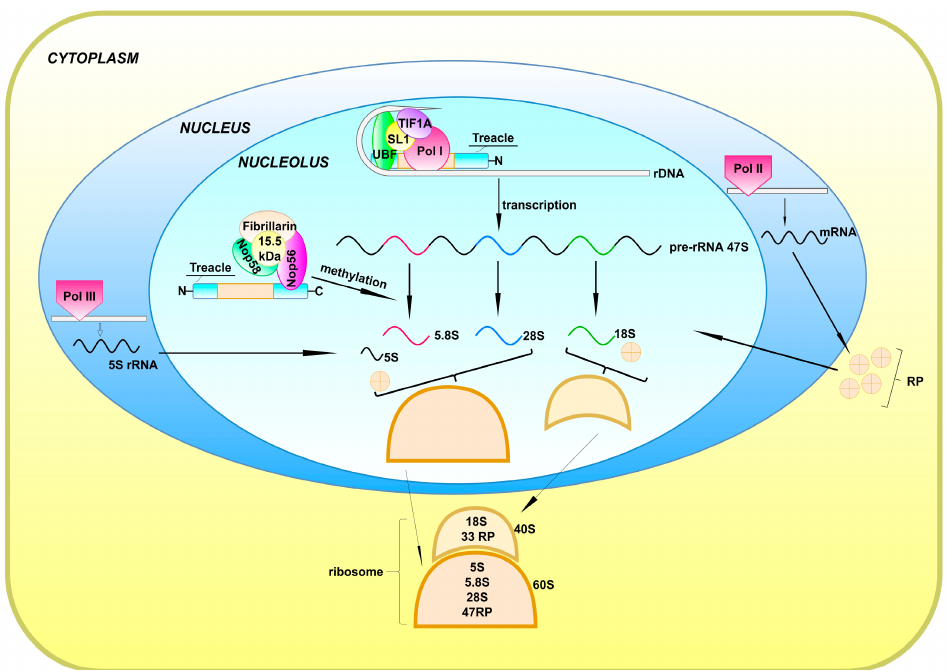
Figure 2. Ribosome biogenesis begins in the nucleolus and is continued during the transport via the nucleoplasm and the final maturation steps that occur in the cytoplasm. The treacle protein recruits the pre-initiation complex (UBF, SL-1, Pol I with associated TIF1A) to the rDNA promoter region [40]. The produced 47S pre-rRNA undergoes post-transcriptional processing (including methylation and possibly pseudouridylation), involving treacle, which binds ribonucleoprotein methylation complex composed of Nop56, fibrillarin, Nop58, and 15.5 kDa protein [32,41]. As a result of the post-transcriptional processing, 5.8S, 18S, and 28S RNAs are generated. The residual ribosome components are synthesized in the nucleoplasm and cytoplasm—Pol III transcribes a gene encoding 5S RNA, which is then transported to the nucleolus; Pol II transcribes genes encoding ribosomal proteins, resulting in mRNAs that are transported to the cytoplasm where translation of ribosomal proteins (RPs) takes place. RPs are then translocated to the nucleolus, where ribosome subunits are formed—the large one (60S), composed of 5S, 5.8S, 28S and 47RP, and the small one (40S), composed of 18S and 33RP. The ribosome subunits migrate to the cytoplasm where the mature ribosome is assembled